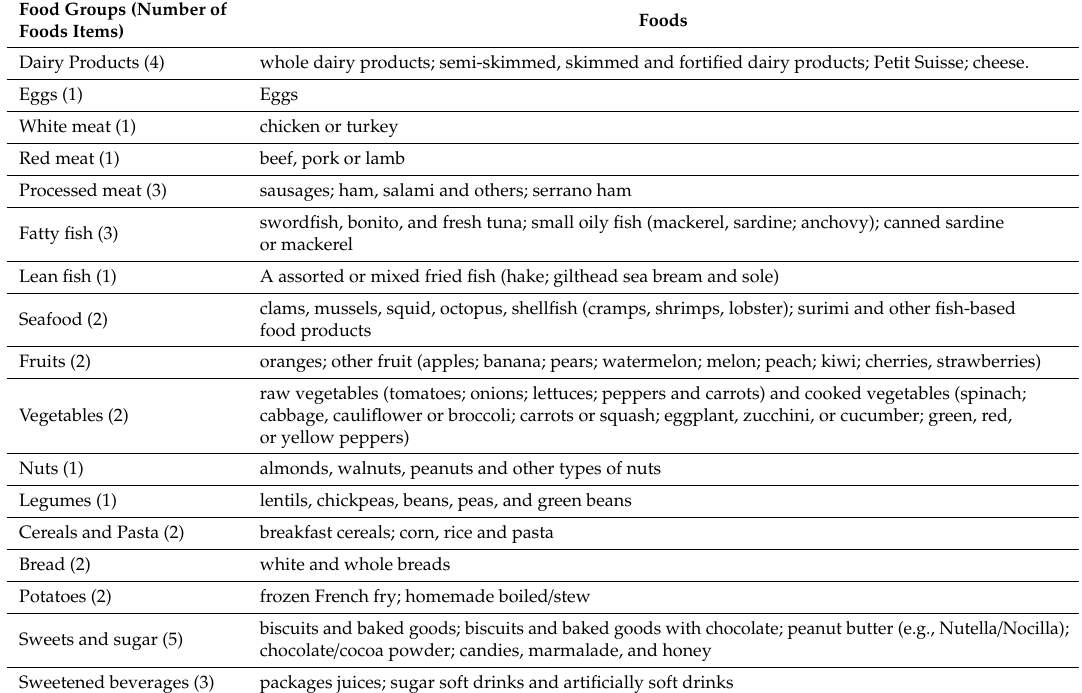
Table 1. Description of the food items included in the food